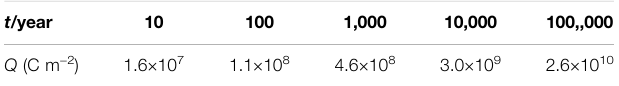
Frontiers in Materials |